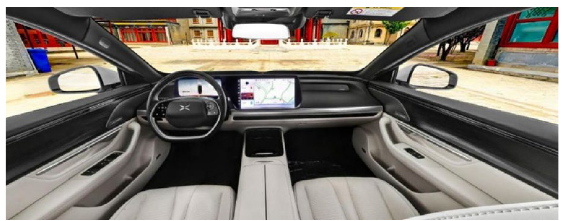
Figure 2. Interior view of the cockpit of the Xiao-Peng P7 automobile.